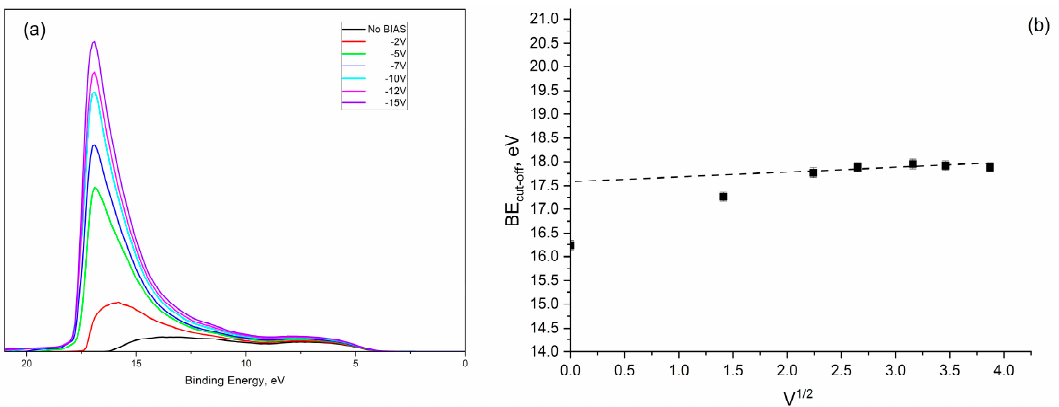
Figure 12. UPS spectra (He I) acquired by applying different bias voltages to the sample ( a ) and the plot of BE cutoff vs. | V | 1/2 ( b ) .